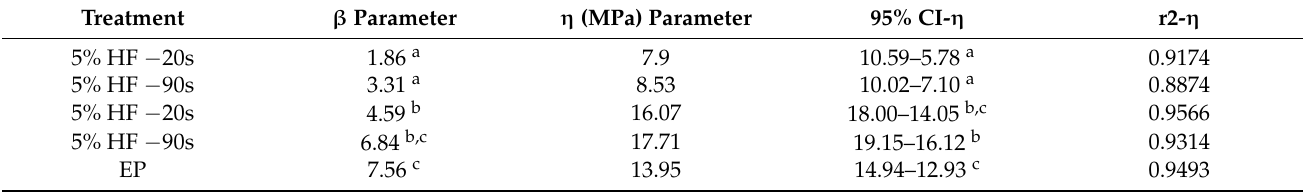
Table 2. Results of the shear bond strength test (Weibull parameters).